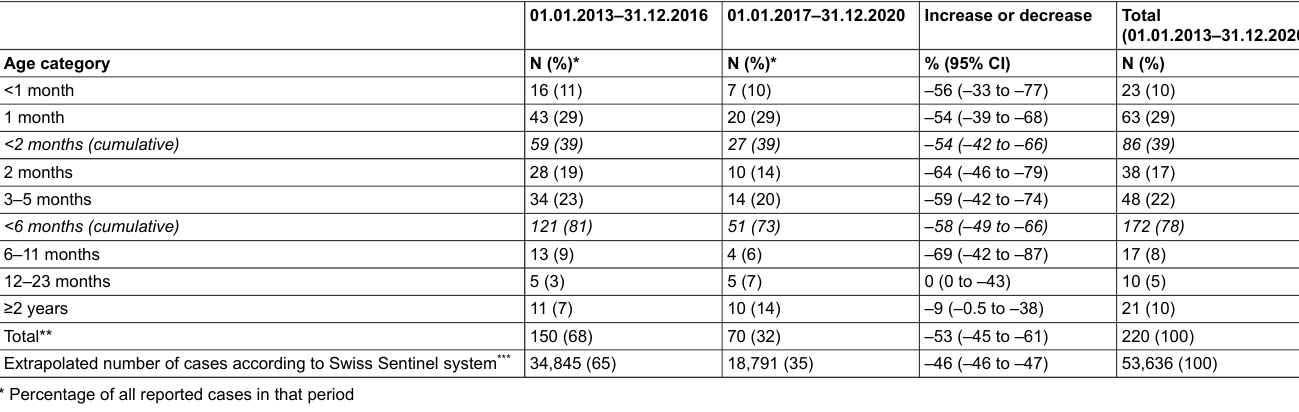
Table 1: Case counts by age category and surveillance period (modified from table 1 in [6]).